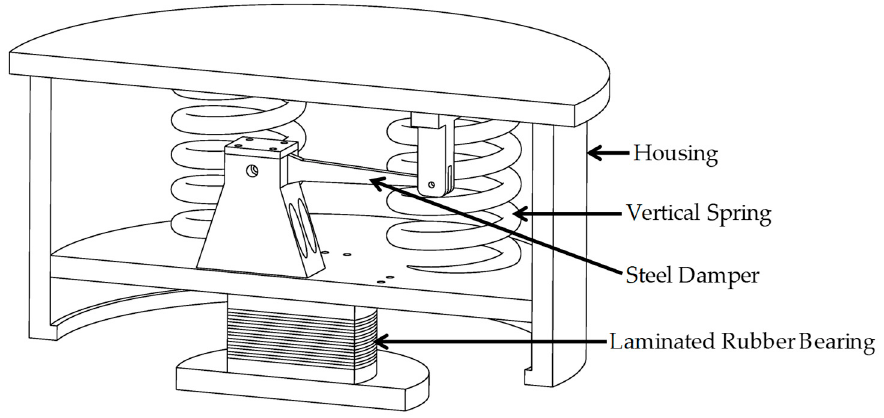
Figure 1. Overall design concept of integrated 3-dimensional seismic isolator (half-symmetric view).